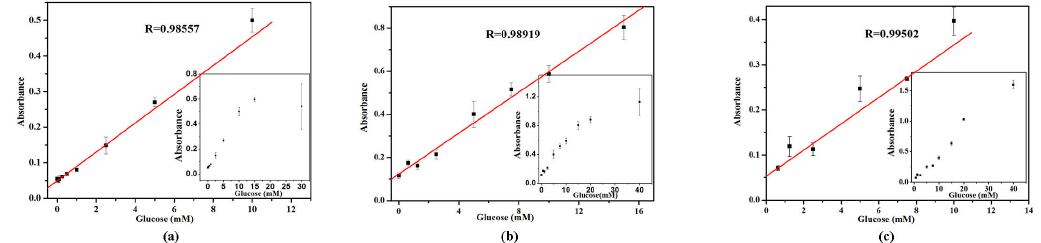
Figure 9. A dose-response curve depending of the absorbance at 656 nm in the presence of different concentrations of glucose. ( a ) VO 2 nanofibers; ( b ) VO 2 nanosheets; ( c ) VO 2 nanorods, in which error bars represent the standard deviation of three measurements. Conditions: pH, 4.0 (0.2 M citrate buffer); temperature, 25 °C; incubation time, 5 min. Table 2. Comparison of different nanozymes for the detection of H 2 O 2 . Linear